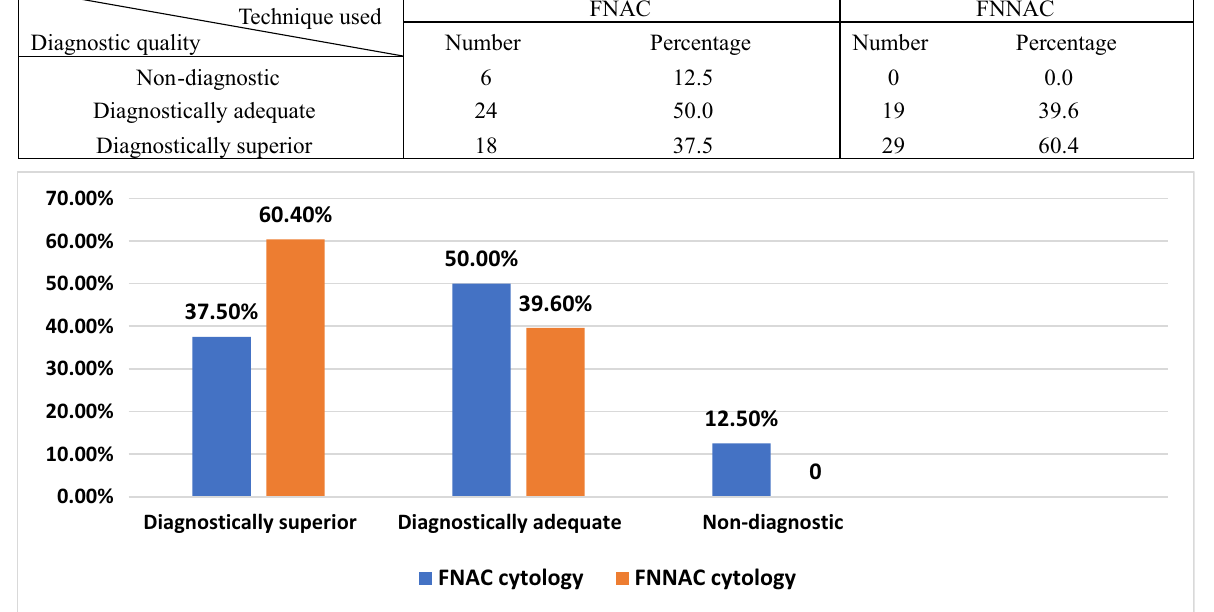
Table 4 diagnostic quality categories percentage with each technique Technique